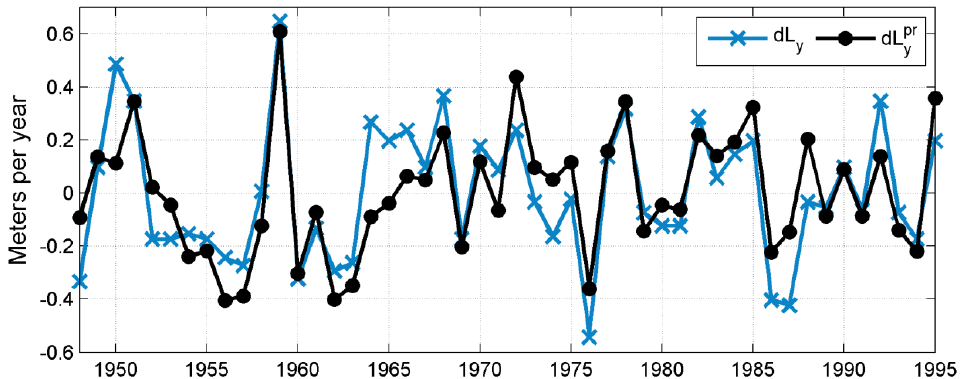
Figure 3. Annual lake-level changes (July–August) estimated from observed levels ( (cid:1856)(cid:1838) (cid:3052)(cid:3022) ; blue x’s) and as computed by Equation (2) ( (cid:1856)(cid:1838) (cid:3052)(cid:3043)(cid:3045) ; black